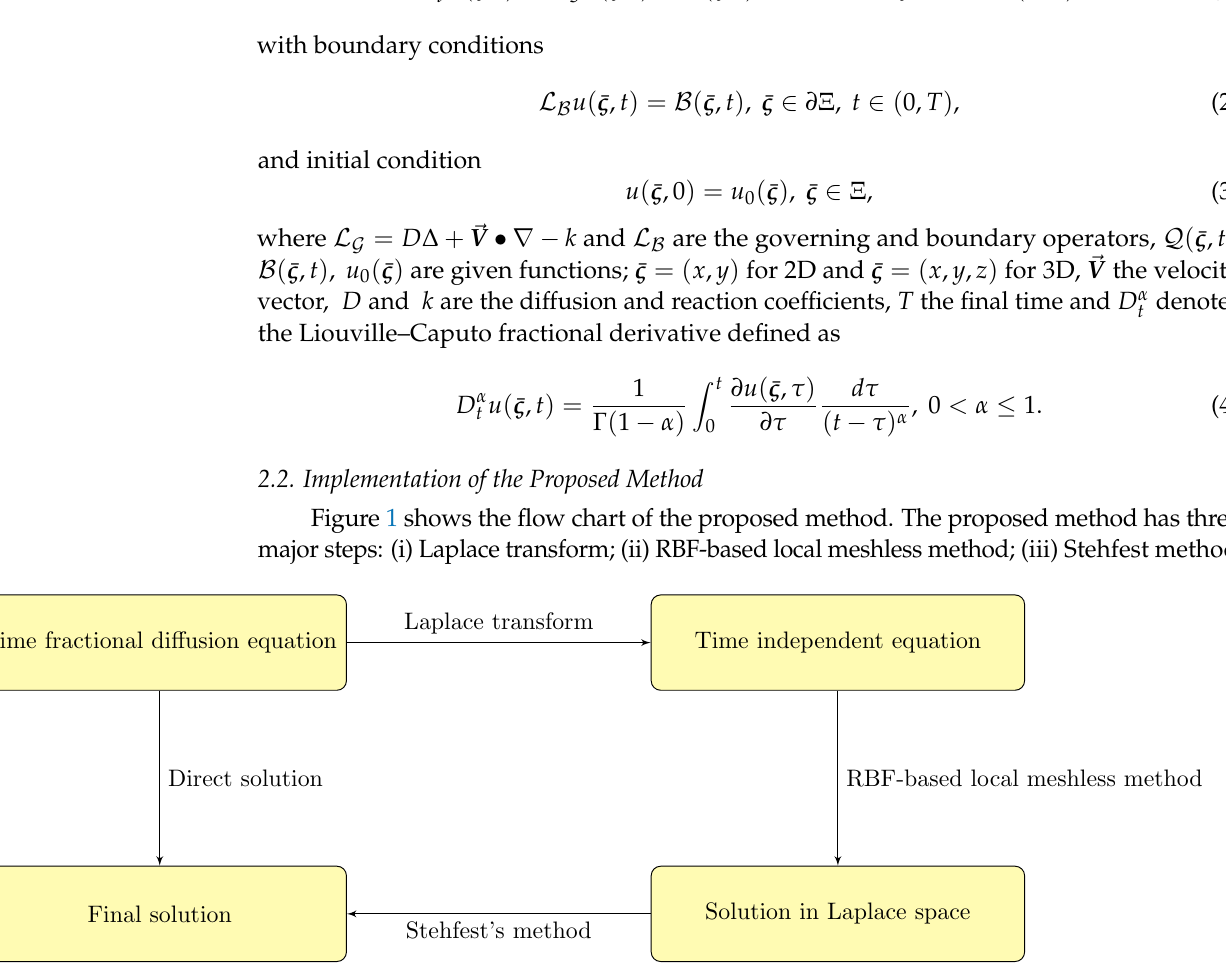
Figure 1. The flowchart of the proposed Figure 1: The flowchart of the proposed method.